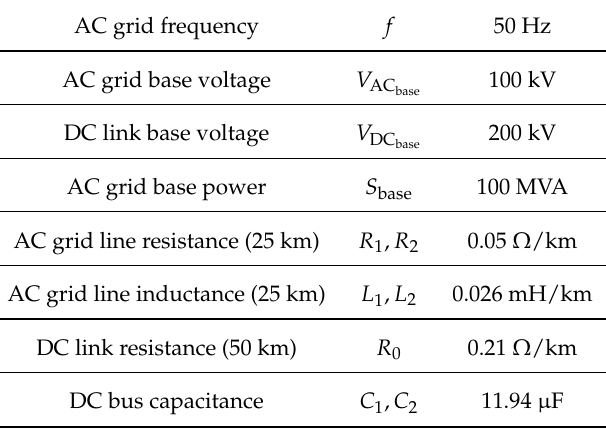
Table 1. System parameters used in the Section